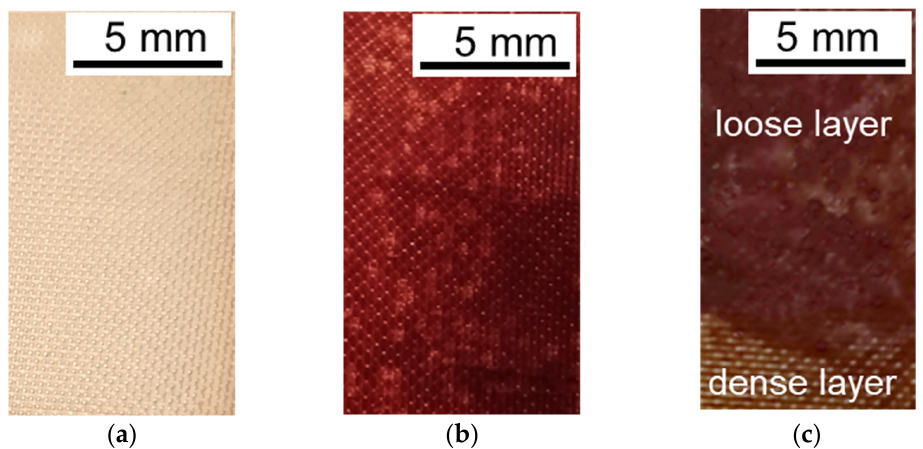
( c ) Figure 7. Photo of the surface of the CJMC-5 membrane before ( a ) and after its using in ED pro- cessing model solutions 3 ( b ) and 4 ( c ). The color of these “islands” coincides with the color of dilute model solutions (Figure 6) and practically does not differ in the case of solution 3 (contains Ant and PACs) and in the case of solution 4 (contains Ant, PACs and fructose). Apparently, the staining indicates little adsorption of polyphenols (Ant and PACs) to those regions of the CJMC-5 cation- exchange membrane that contain a higher concentration of the aromatic cross-linker. Only microcavities on the surface of CJMC-5 (SM, Figure S8a), which could appear during membrane storage, have a more intense burgundy color. As in the absence of an electric field, these cavities, as well as outputs to the surface of CJMC-3 macropores between the ion-exchange material and the reinforcing cloth threads, serve as the main “gates” for the penetration of high-molecular-weight polyphenols into the membrane. On the contrary, the entire surface of the CJMA-6 anion-exchange membrane is cov- ered with a burgundy (Figure 8b) and brown (Figure 8c) sediment of colloidal particles,